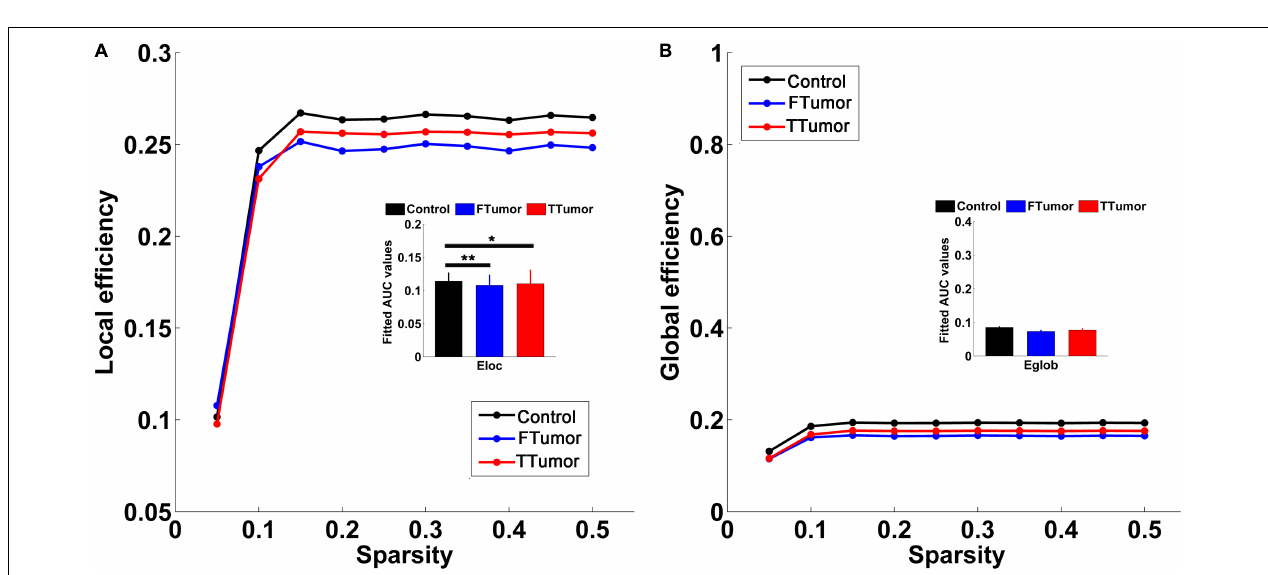
FIGURE 4 | Global and local efficiencies of WM structural networks across the sparsity among the control, FTumors, and TTumors. FTumors, frontal tumors; TTumors, temporal tumors; WM, white matter. (A) indicating comparison of local efficiency among three groups; (B) indicating comparison of global efficiency among three